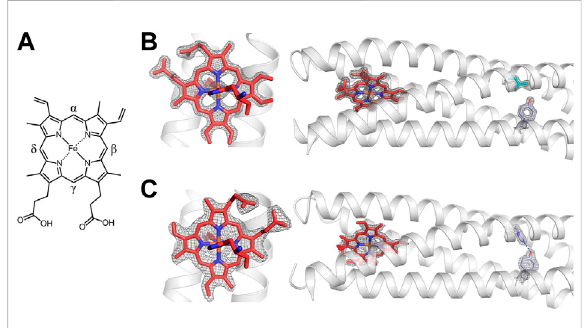
FIGURE 8 A Leu71His mutation distant from the A -site triggers a 90 ° rotation of heme B. (A) Chemical structure of heme B. (B) The 1.45 Å resolution crystal structure with heme B and Leu71 (PDB ID: 5VJT). Left: close-up of A -site is shown with 2.0 σ contouring of (F obs , φ calc ) map around heme B. Right: larger context of same structure shows heme B, Leu71, and Tyr168 with 2.0 σ contouring. (C) The 2.08 Å resolution crystal structure with heme B and a His71-Tyr168 hydrogen bond (PDB ID: 5VJU). Left: close-up of A -site in Leu71His mutant is shown with 1.0 σ contouring of (F obs , φ calc ) map around heme B. Right: larger context of same structure shows heme B and His71-Tyr168 hydrogen bond (indicated by blue dashed line) at 1.5 σ